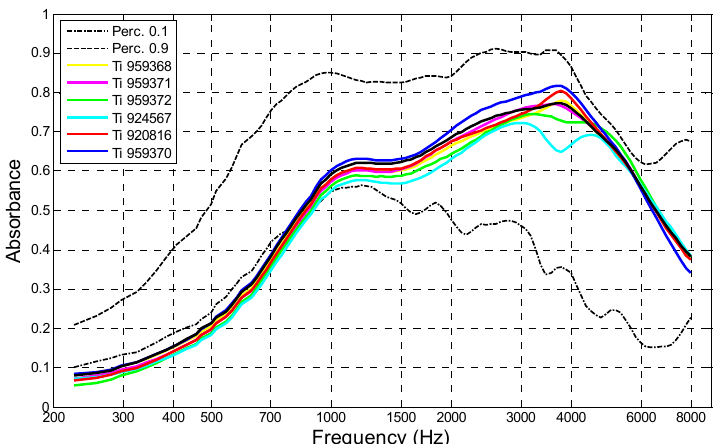
Figure 2. Absorbance–frequency characteristics of an artificial ear (BK4128C) measured with seven instruments used in the tests (Titan IMP440 / WBT440). Dotted lines denote 10% and 90% absorbance limits for normal human ears.